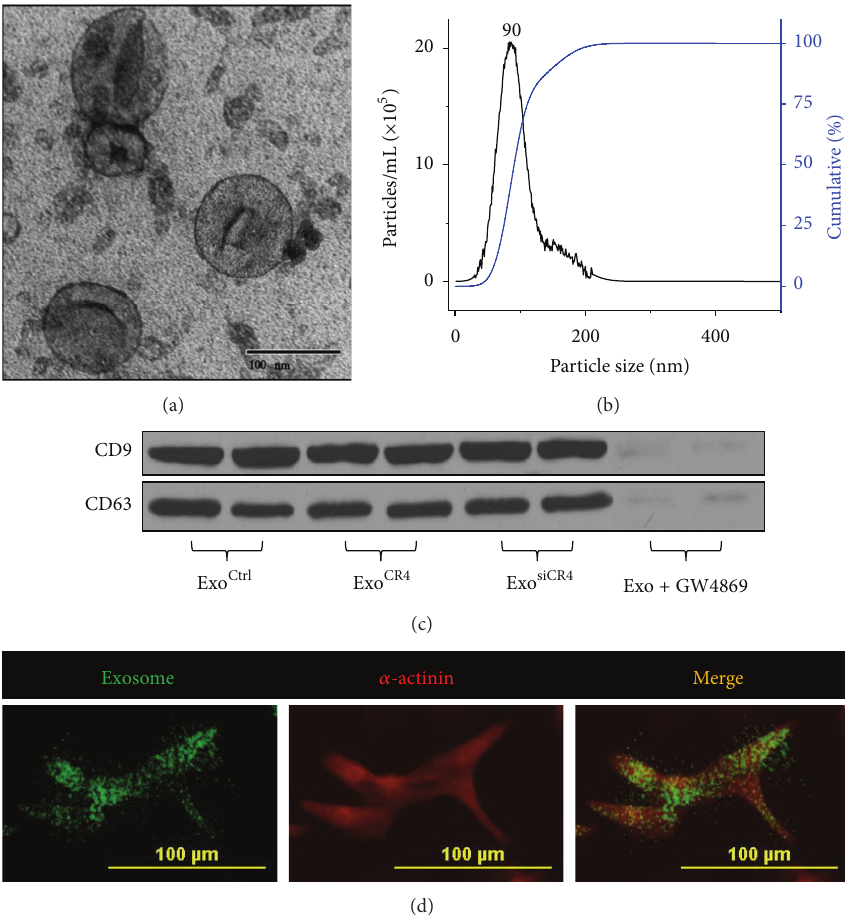
Figure 1: Characterization of MSC-derived exosomes. (a) Transmission electron microscopy (TEM) micrograph of exosomes purified from MSC. Isolated exosomes showed spherical and membrane encapsulated with the diameters varying between 40 and 90nm. (b) Representative dynamic light scattering (DLS) number distribution measurement of isolated exosome population demonstrates a single peak ( ∼ 90nm diameter) indicating they are free of contamination. (c) Expression of specific exosomal markers, CD9 and CD63, in exosomes was identified by Western blotting. Exo Ctrl , exosomes isolated from MSC transfected with null lentivirus (MSC Ctrl ); Exo CR 4 , exosomes isolated from MSC transfected with lentivirus overexpressing CXCR4(MSC CR 4 ); Exo siCR 4 , exosomes isolated fromMSC transfected with lentivirussiRNA against CXCR4 gene (MSC siCR 4 ); Exo + GW4860, exosomes isolated from MSC with additional sphingomyelinase inhibitor GW4860. (d) Uptake of exosomes by neonatal cardiomyocytes (CM). CM were stained by cardiac specific antibody, sarcomeric 𝛼 -actinin (red). MSC CR 4 -derived exosomes were labeled with PKH67 (green) and incubated with CM for